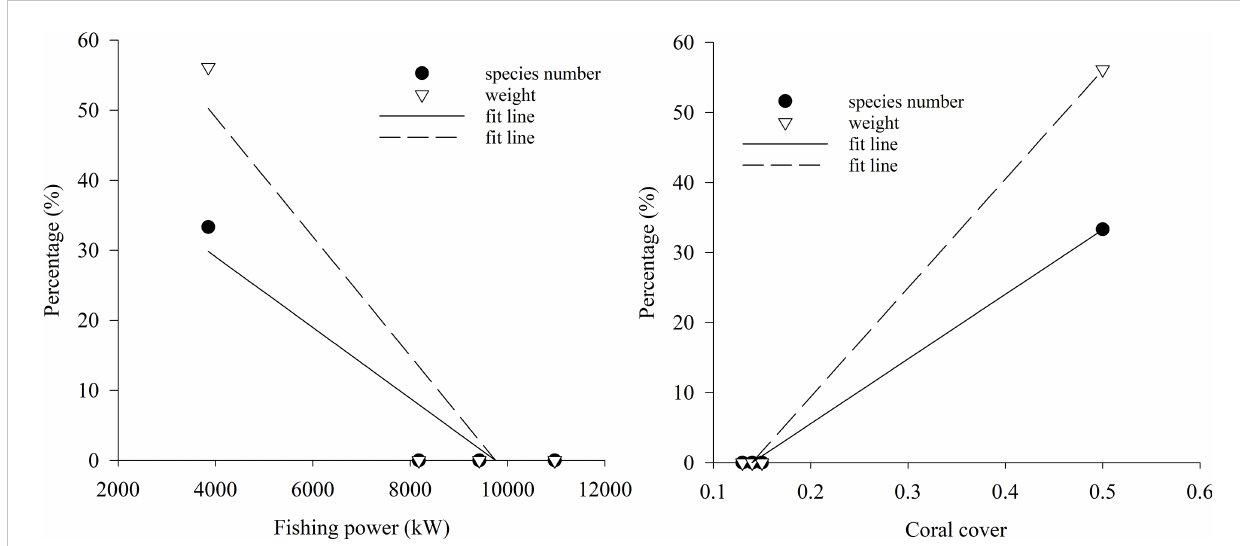
FIGURE 9 Scatter plot and linear fi t between percentages of species number and weight of herbivorous fi shes by gillnet in the lagoon of in Meiji Reef and fi shing power and coral cover in 1999 and 2016 —